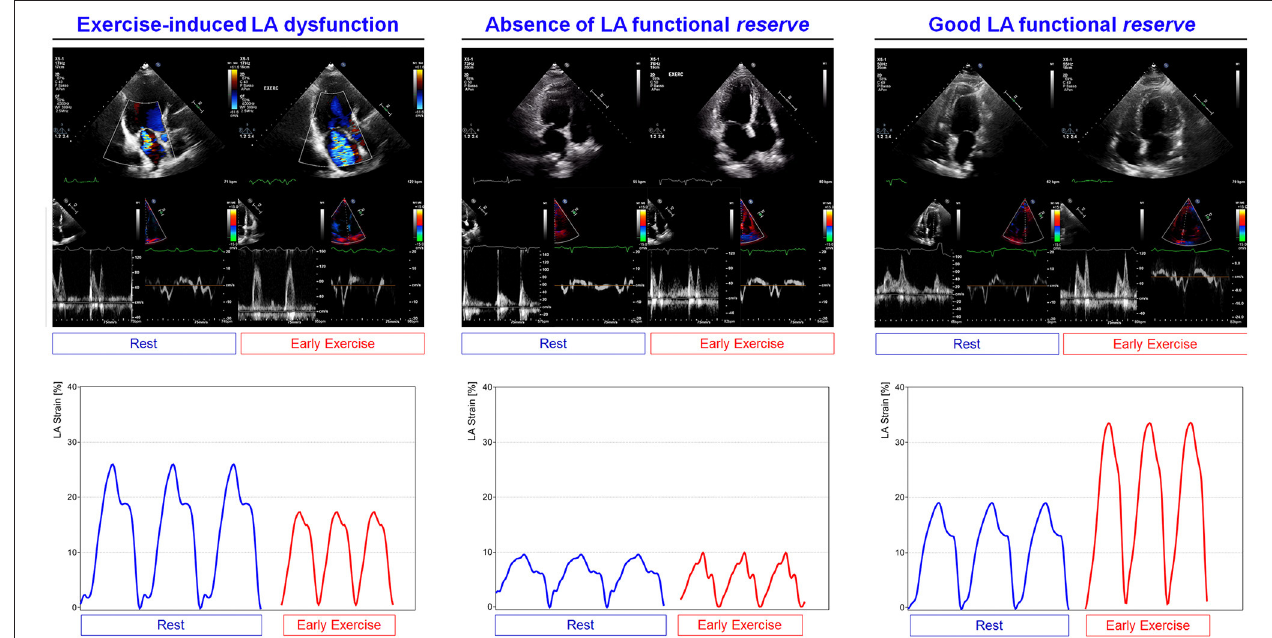
FIGURE 7 | LA functional reserve assessed during exercise in HFrEF. Examples of rest-stress traces of patients with different severity of HFrEF. (left) Exercise-induced LA dysfunction; (middle) absence of LA functional reserve in severely impaired LA mechanics; (right) good LA functional reserve. Note that during early stage of exercise, LA mechanics can improve or reduce according with the presence of functional reserve, expression of multiple factors influencing LA function. In the first case on the left, the presence of exercise-induced mitral regurgitation produces additional volume overload responsible of further reservoir function worsening. Abbreviations as in the